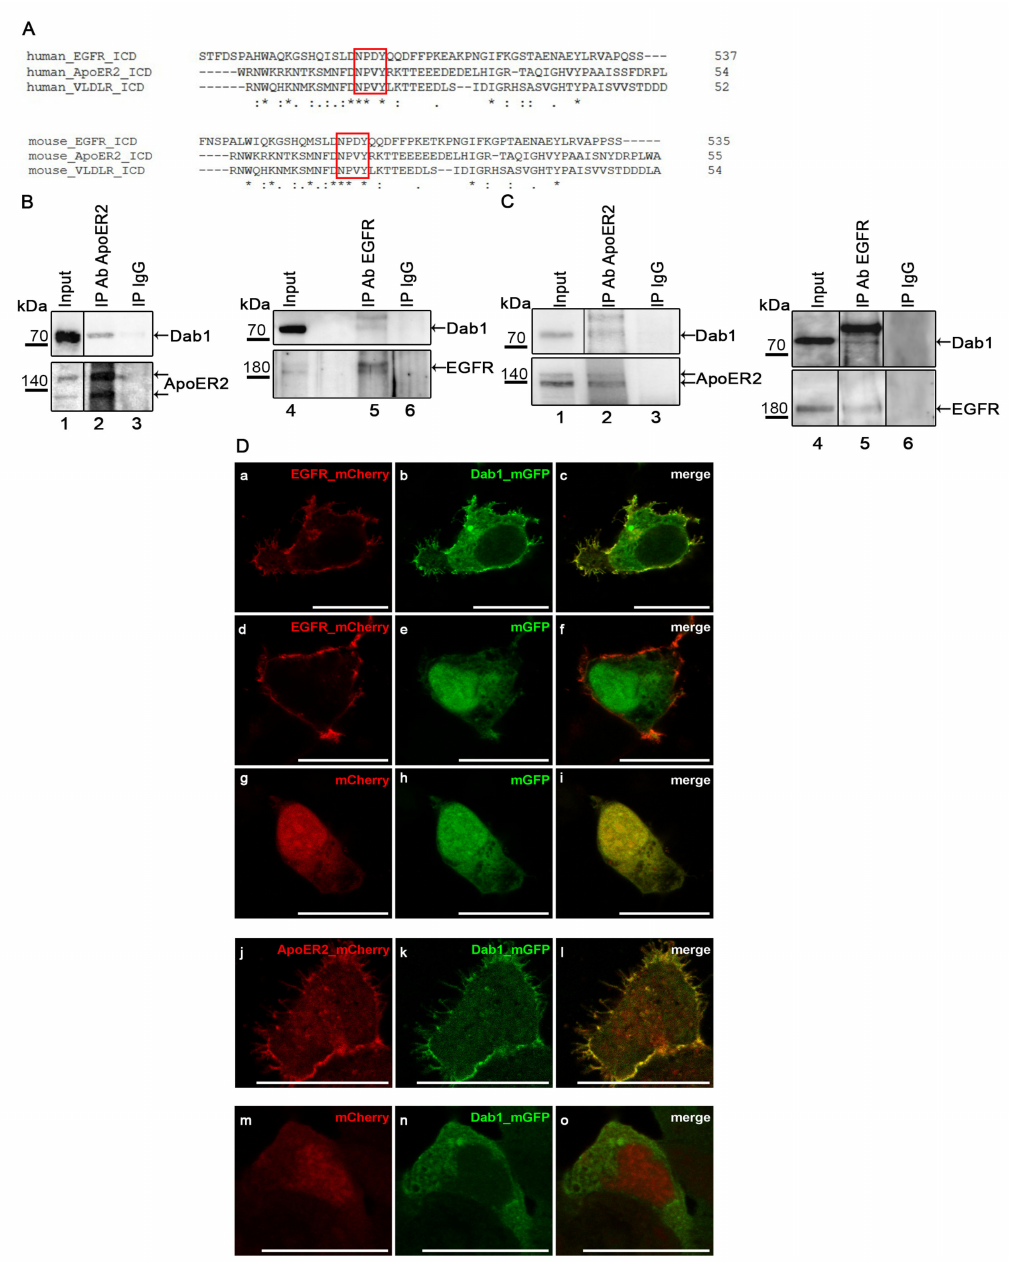
Figure 1. Disabled 1 (Dab1) interacts with epidermal growth factor receptor (EGFR). ( A ) Sequence alignment of hu- man/murine apolipoprotein E receptor 2 (ApoER2), very low density lipoprotein receptor (VLDLR) and EGFR intracellular domains was generated with Clustal Omega. NPxY motifs present in the intracellular domains of the receptors are marked by red boxes. “*” residues are identical in all sequences in the alignment, “:” conserved substitutions, “.” semi-conserved substitutions. ( B ) Western blot analysis of protein extracts from HEK293 cells expressing ApoER2 and Dab1 (Lane 1, input) or EGFR and Dab1 (Lane 4, input) which were subjected to immunoprecipitations using an antibody specific to ApoER2 (Lane 2) or EGFR (Lane 5) or an unrelated rabbit IgG antibody (Lane 3) or mouse IgG antibody (Lane 6). In upper panels Dab1 levels were detected by using a Dab1 specific antibody (Ab D4). The blots were stripped and re-probed with an ApoER2 or EGFR specific antibody (lower panels) as a pulldown control. ( C ) Murine embryonic neurons (E15.5) were lysed and the protein extract was subjected to immunoprecipitation using an antibody specific to ApoER2 (Lane 2) or EGFR (Lane 5) or unrelated rabbit (Lane 3) or mouse IgG (Lane 6) as a control. The extracts and precipitates were analyzed by western blotting. The vertical line indicates that the blot was spliced. ( D ) HEK293 cells expressing fluorescently tagged variants of ApoER2 ( j ), EGFR ( a , d ) and Dab1 ( b , k , n ) or fluorophores alone; mGFP ( e , h ) or mCherry ( g , m ) were imaged by confocal fluorescence microscopy. Merged images are presented in ( c , f , i , l , o ). Scale bar represents 20 µ